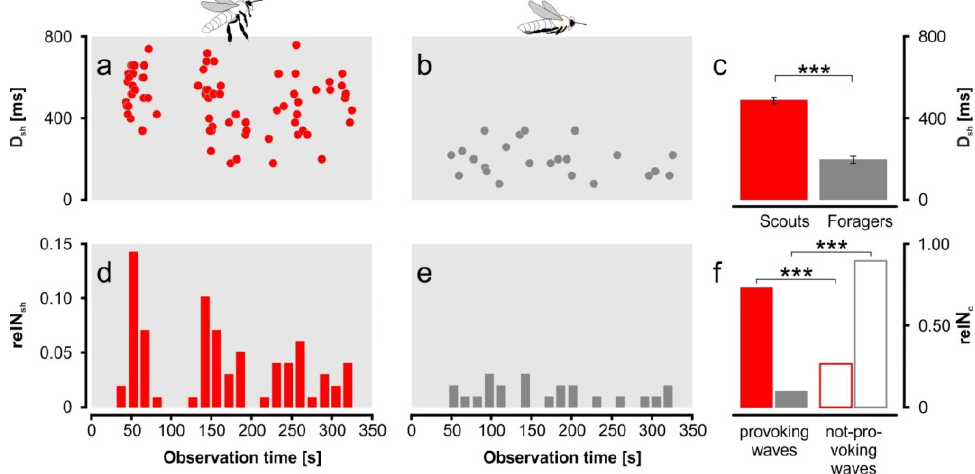
Figure 3. Shimmering behaviour ( expN ), duration of waves (D ) in ms (ordinate), provoked 1 sh by ( a ) “non-nestmate” scouts (red) and by ( b ) homing “nestmate” foragers (grey) over observation time (326 s); ( c ) shimmering waves evoked by “non-nestmates” were significantly longer (means ± SEM of D ; p < 0.001; t -test). Relative rates of shimmering waves ( n ) per sh rel sh 15 s intervals provoked by ( d ) “non-nestmates” and by ( e ) foragers over observation time; ( f ) scouts more often provoked shimmering waves (solid bars), but the relative number of approaches (outlined bars) without provoking shimmering waves was much lower.